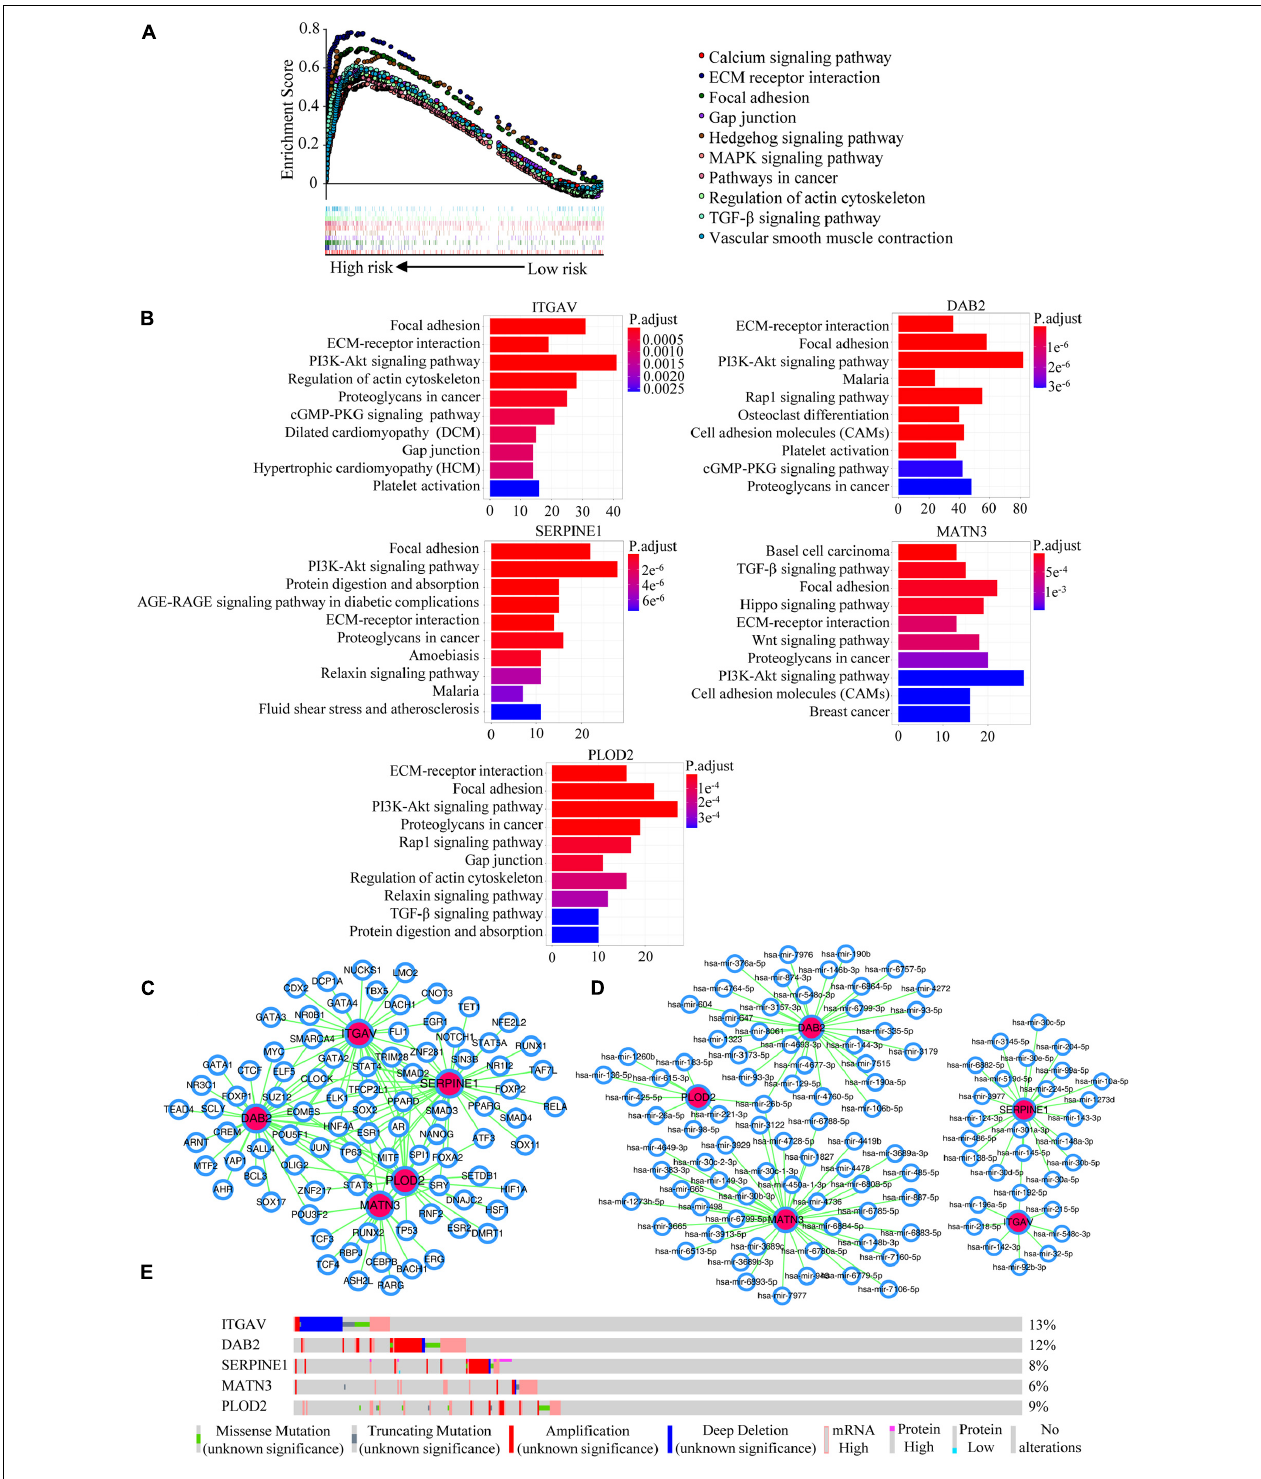
FIGURE 7 | Potential mechanisms mining of the EMT-related signature. (A) GSEA analysis for the EMT-related signature. (B) KEGG enrichment analyses for co-expressed genes with EMT-related signature members. (C) The predicted network of TFs and EMT-related signature members in the NetworkAnalyst database. (D) The predicted networks of miRNAs and EMT-related signature members in the NetworkAnalyst database. (E) The genomic alterations of EMT-related signature members in the cBioportal database.